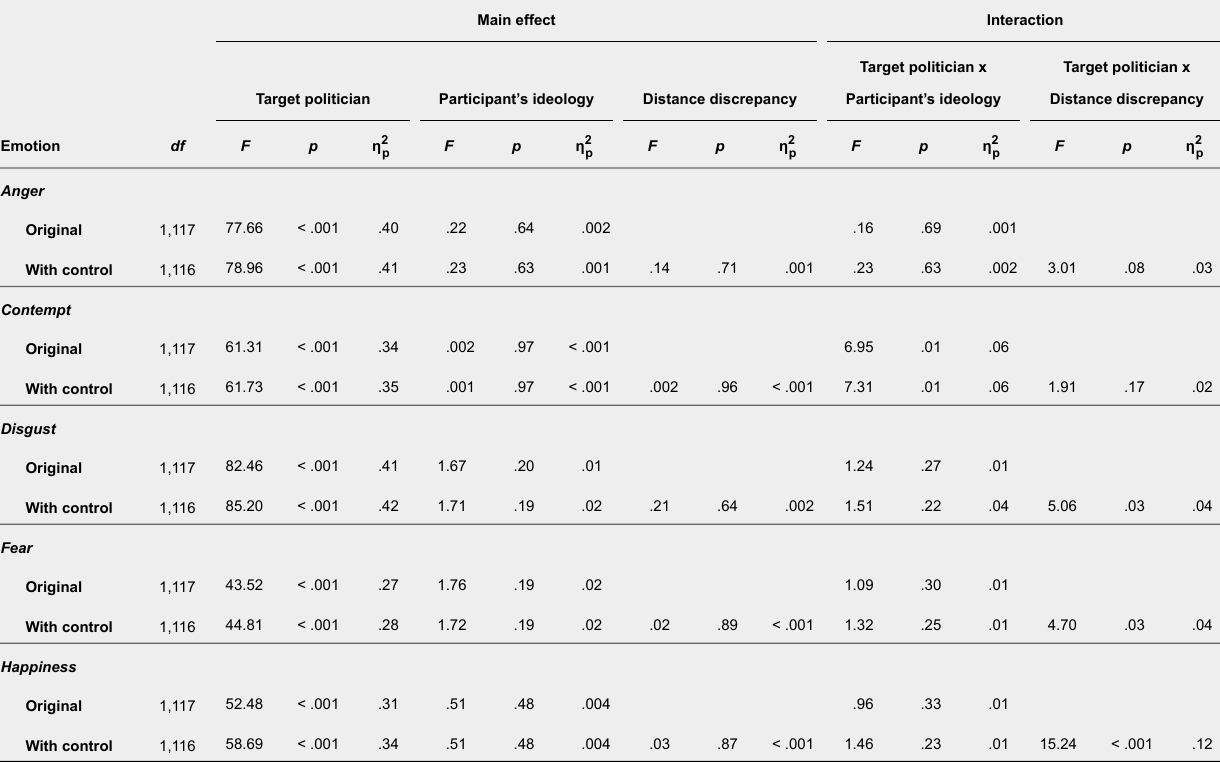
Study 1 ANOVA Statistics While Controlling for Ideological Distance Discrepancy